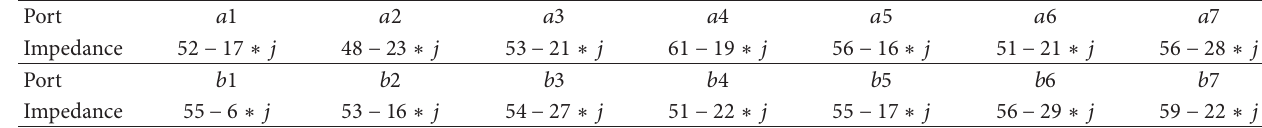
Table 2: Measured improved input impedance of each port.